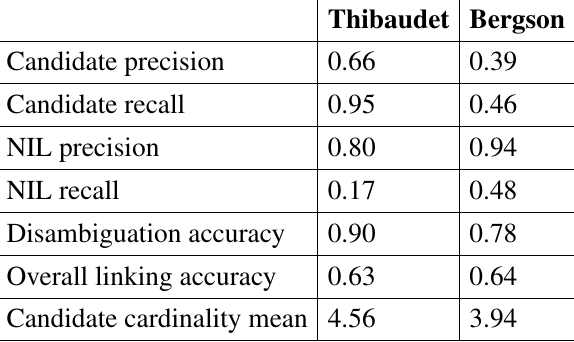
Table 1. REDEN evaluation results for the